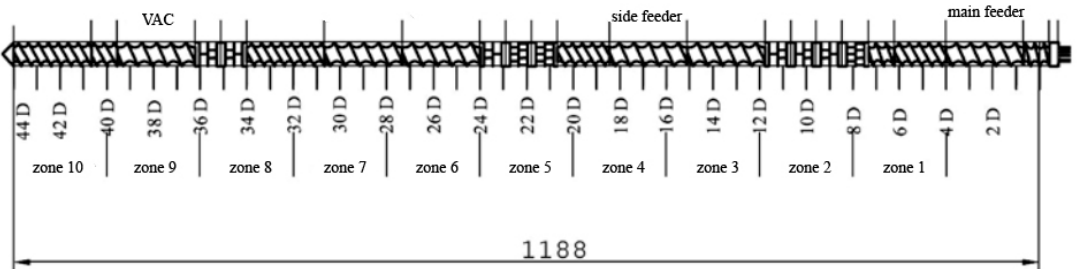
Figure 1. Screw configuration applied for the preparation of analyzed samples.